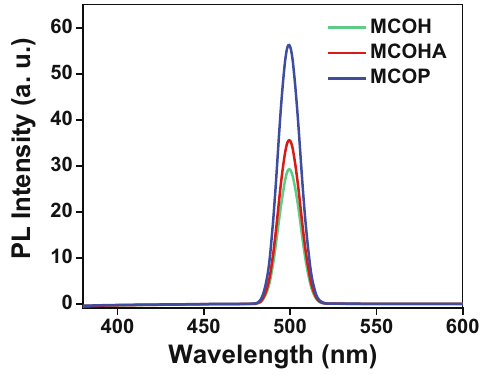
Figure 10: PL spectra of the MCO samples.